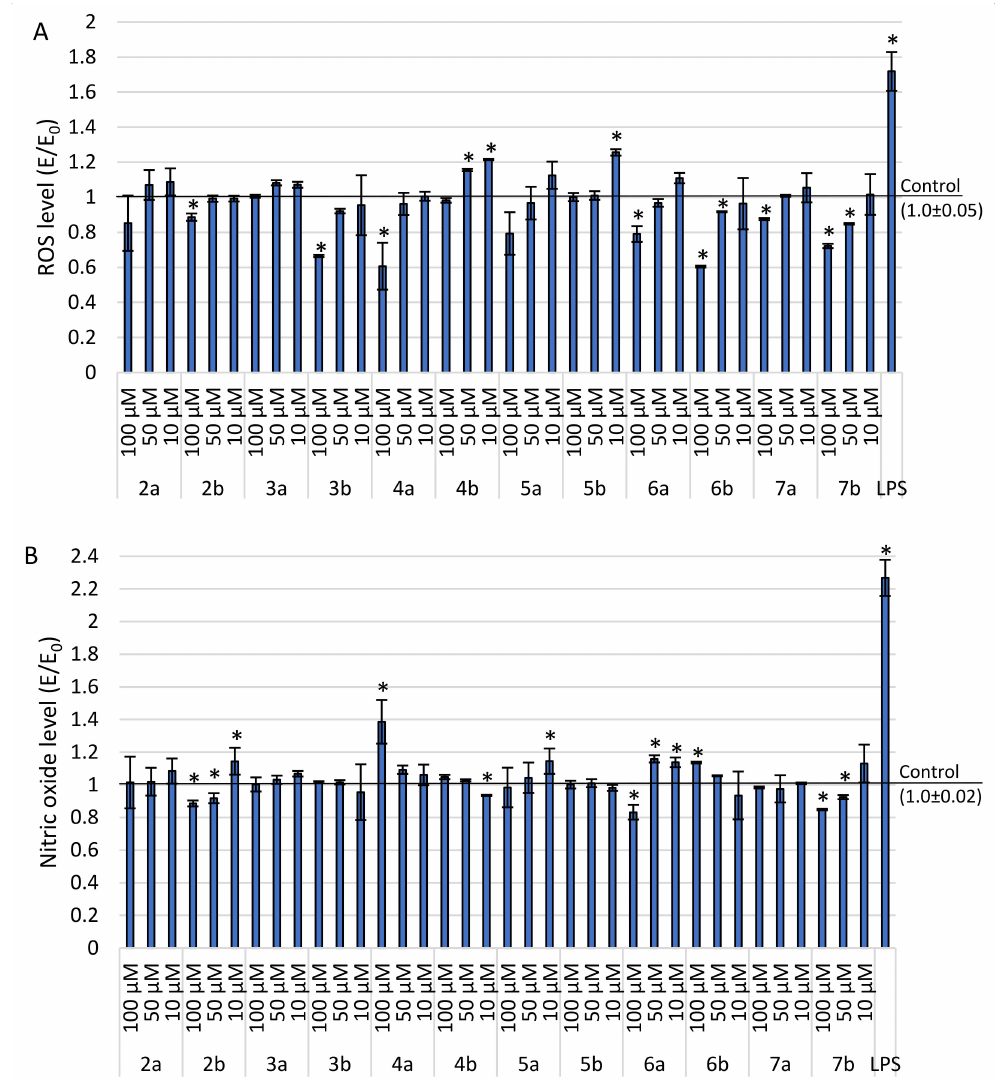
Figure 5. Impact of investigated compounds on THP-1 cell line incubated with LPS; ( A )—DCF-DA assay, ( B )—Griess assay, * p < 0.05—significant difference compared to control with 50 µ g/mL LPS and without